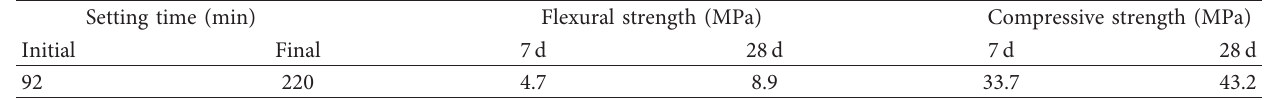
Table 2: Physical properties of the cement.